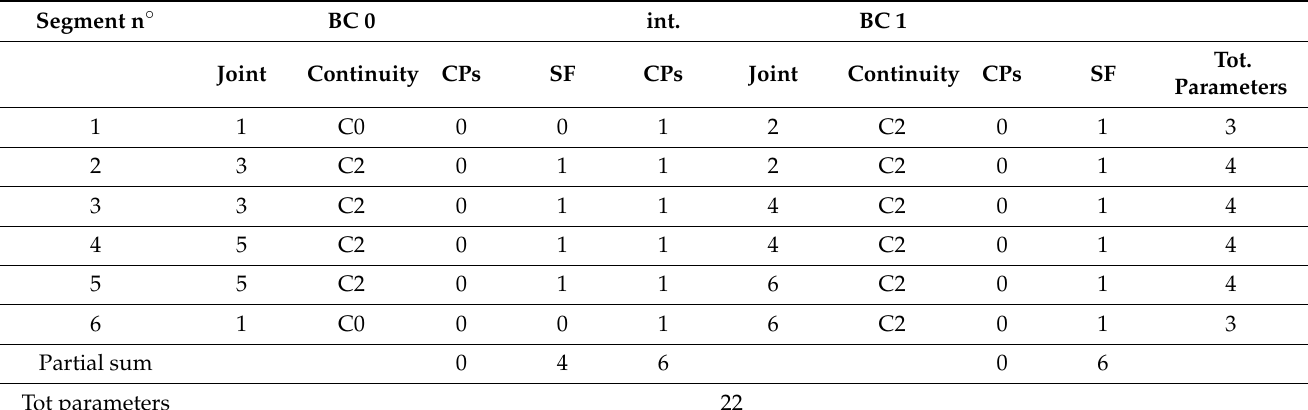
Table 4. Model parameters ensuring C 2 continuity (less model flexibility).